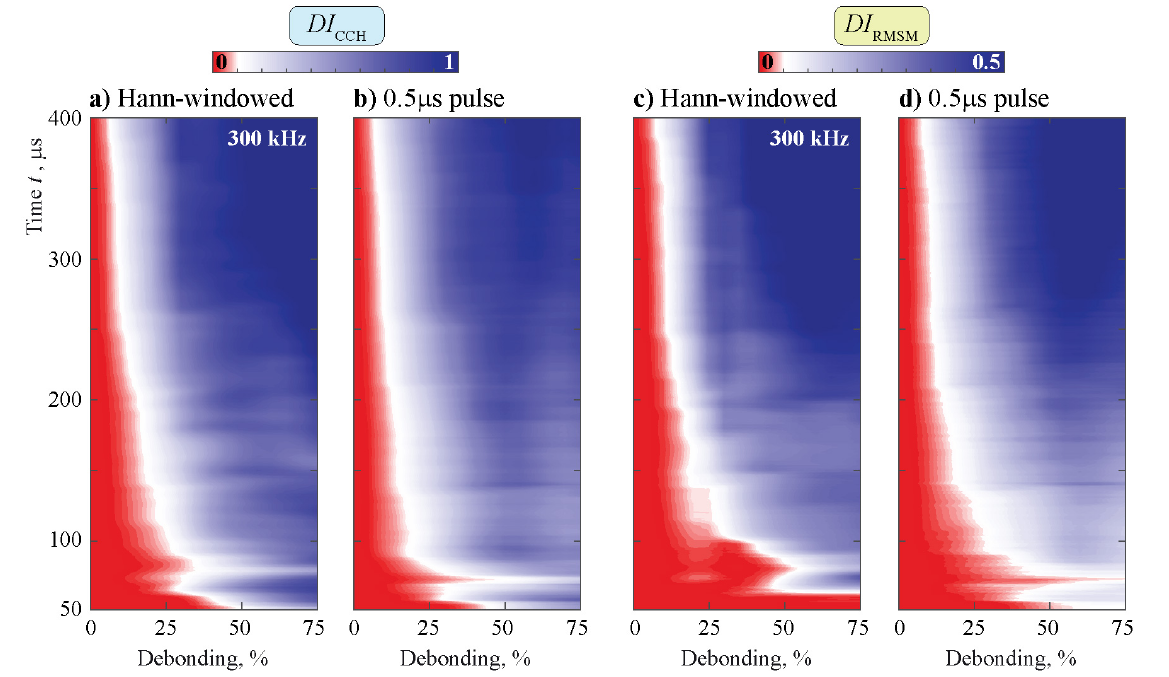
Figure 19. The DI DI m ( a / w , t ) calculated using the data from a sensor at different debondings.